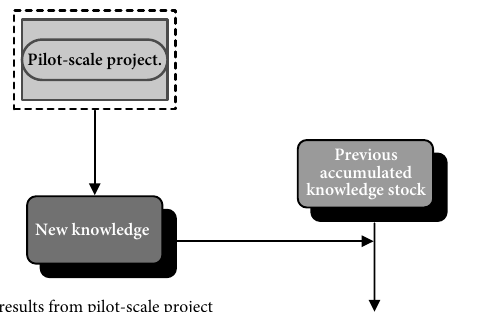
data_type Pilot-scale